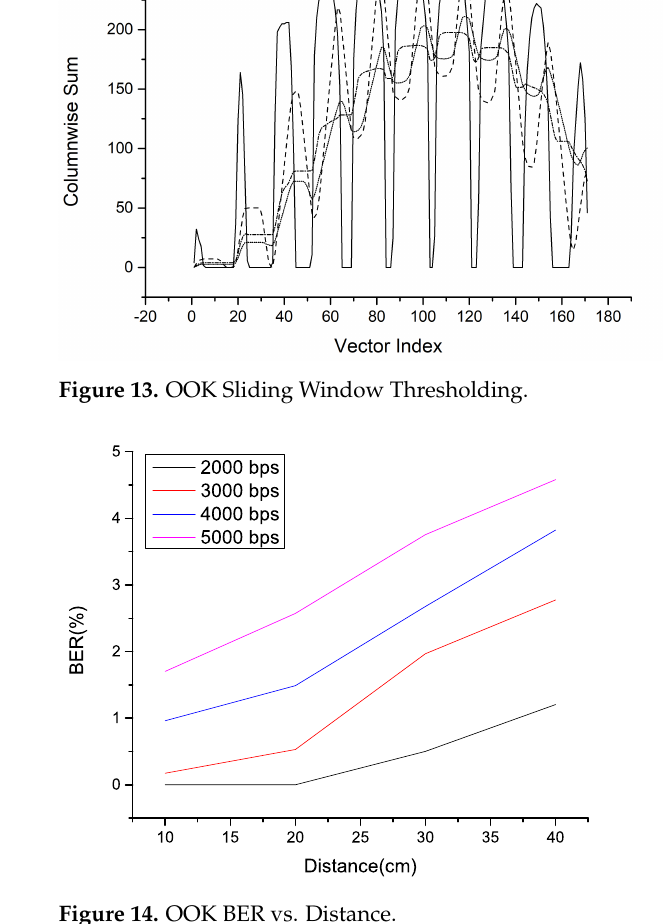
Figure 14. OOK BER vs.